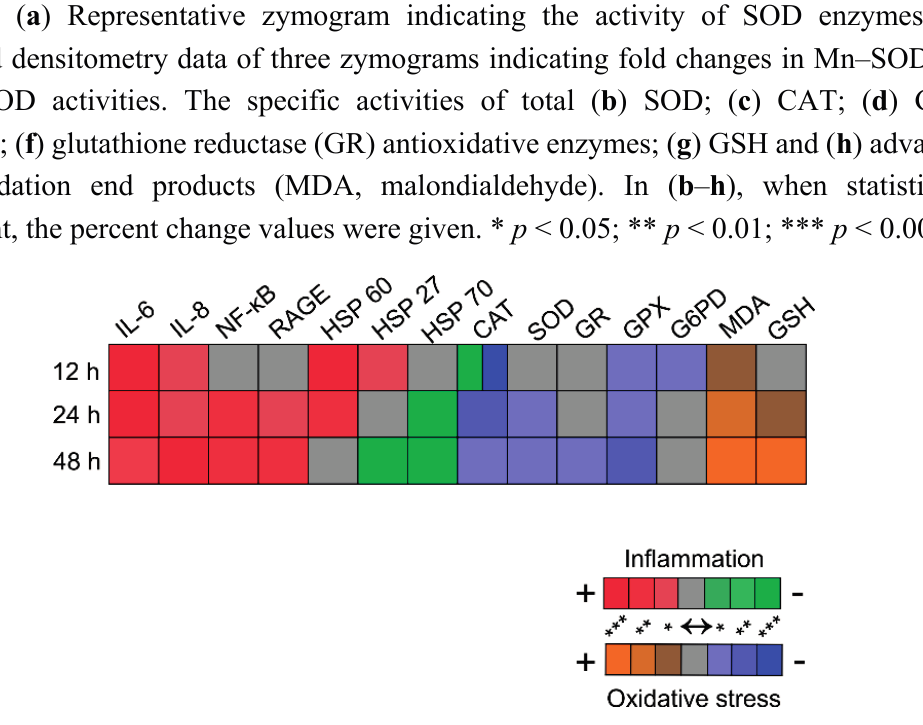
Figure 4. Heat plot indicating the parameters changes and their pro-/anti-inflammatory or the pro-/anti-oxidative contributions, as discussed in the text. The amplitude of the changes is color-coded based on the p value of statistic significance. The relative changes in the extracellular level of cytokines, protein expression levels of NF- κ B, RAGE and HSPs and specific enzymatic activity are shown. * p < 0.05; ** p < 0.01; and *** p <